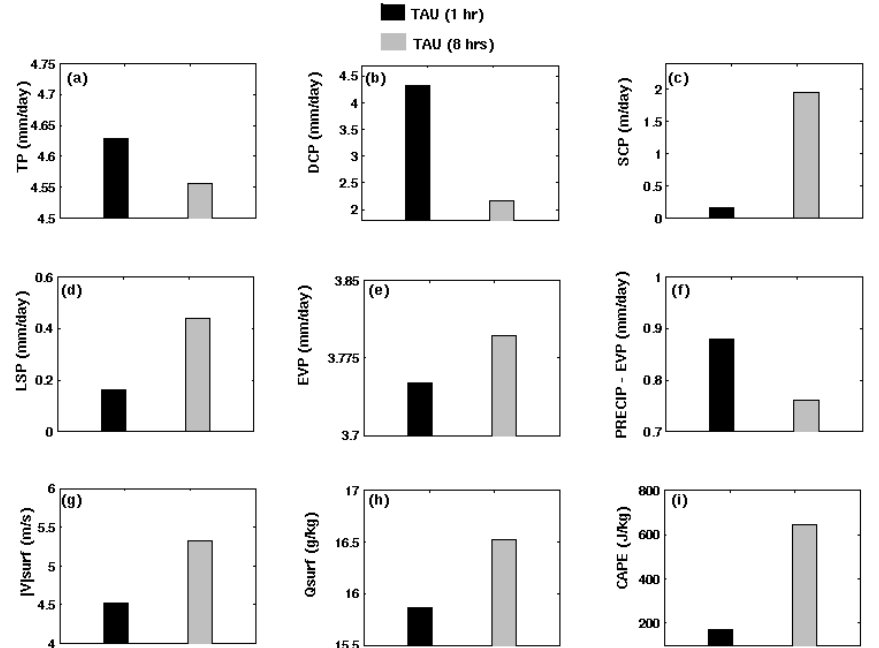
Fig. 17. Area averaged (0 ◦ E to 360 ◦ E and 12.5 ◦ S to 12.5 ◦ N), time mean (all months of 10 years) quantities for TAU (1h) and TAU (8h). (a) TP, in this plot, (b) deep convective precipitation, (c) shallow convective precipitation, (d) large scale precipitation, (e) EVP, (f) PRECIP – EVP, (g) magnitude of wind at 1st model level, (h) specific humidity at the 1st model level, and (i)